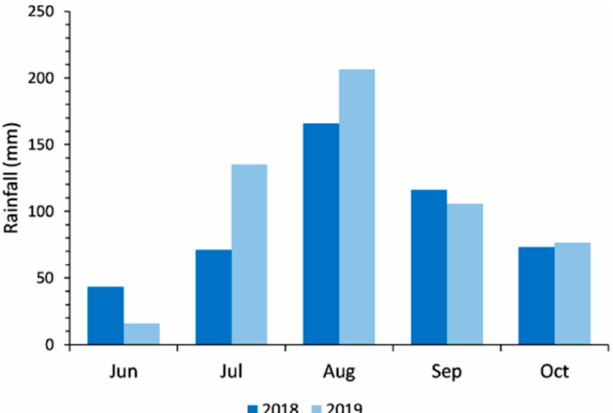
Figure 7. Monthly precipitation during the 2018 and 2019 rainy seasons in a semi-dry forest of Chihuahua,